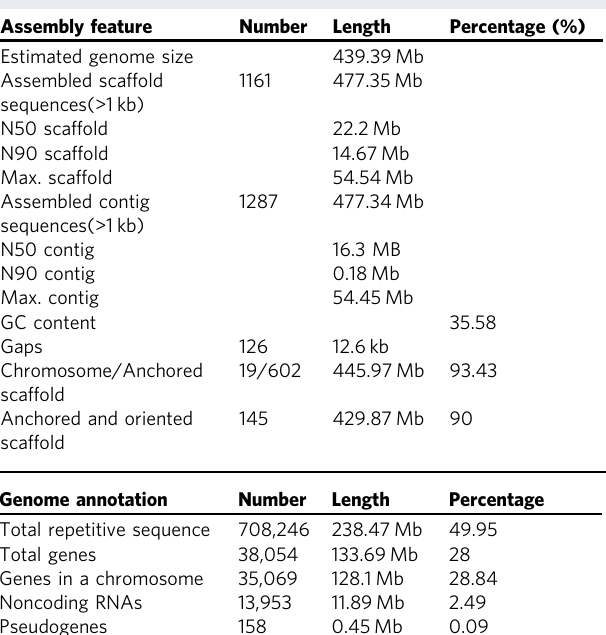
Table 1 Statistics for the P. wilsonii Genome and Gene